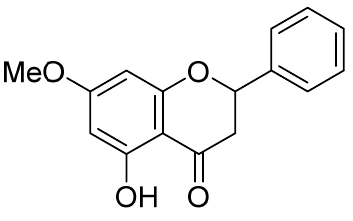
Figure 1. Chemical structure of pinostrobin.